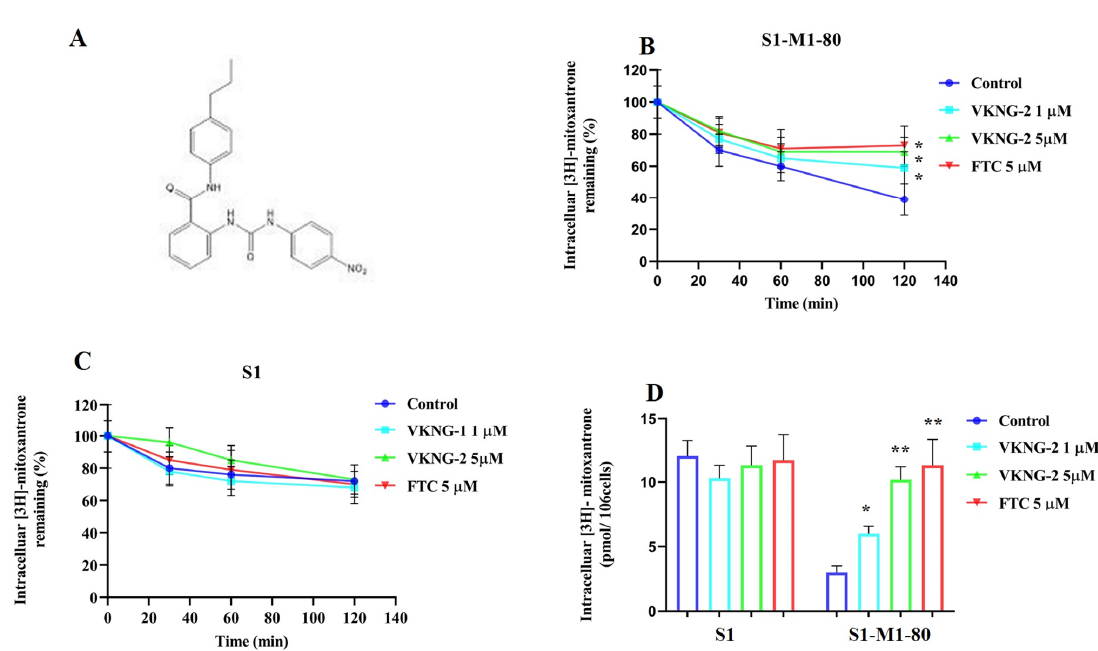
Figure 4. ( A ) The chemical structure of VKNG-2. ( B ) The effect of the incubation of vehicle (Control), VKNG-2 (1 or 5 µ M) or FTC (5 µ M) for 30, 60 or 120 min on the efflux of the ABCG2 transporter substrate, [ 3 H]-mitoxantrone from S1-M1-80 colon cancer cells overexpressing the ABCG2 transporter. ( C ) The effect of the incubation of vehicle (Control), VKNG-2 (1 or 5 µ M) or FTC (5 µ M) for 30, 60 or 120 min on the efflux of the ABCG2 transporter substrate, [ 3 H]-mitoxantrone from S1 parental colon cancer cells. ( D ) The effect of the vehicle (Control), VKNG-2 (1 or 5 µ M) or FTC (5 µ M) on the intracellular accumulation of [ 3 H]-mitoxantrone in S1 and S1-M1-80 colon cancer cells. The columns are the mean of triplicate determinations; the error bars represent the SD. * p ≤ 0.05 and ** p ≤ 0.01 compared with the control group.